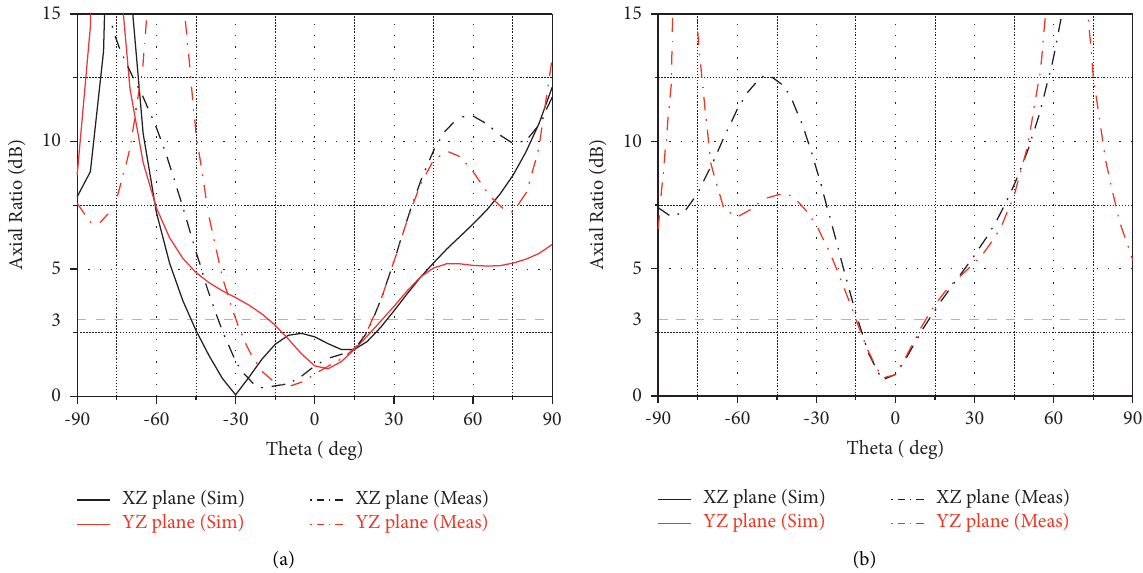
Figure 13: Simulated and measured axial ratio as a function of θ angle from the broadside, in the XZ and YZ planes at 2.45GHz: (a) Port 3 and (b) Port 4.